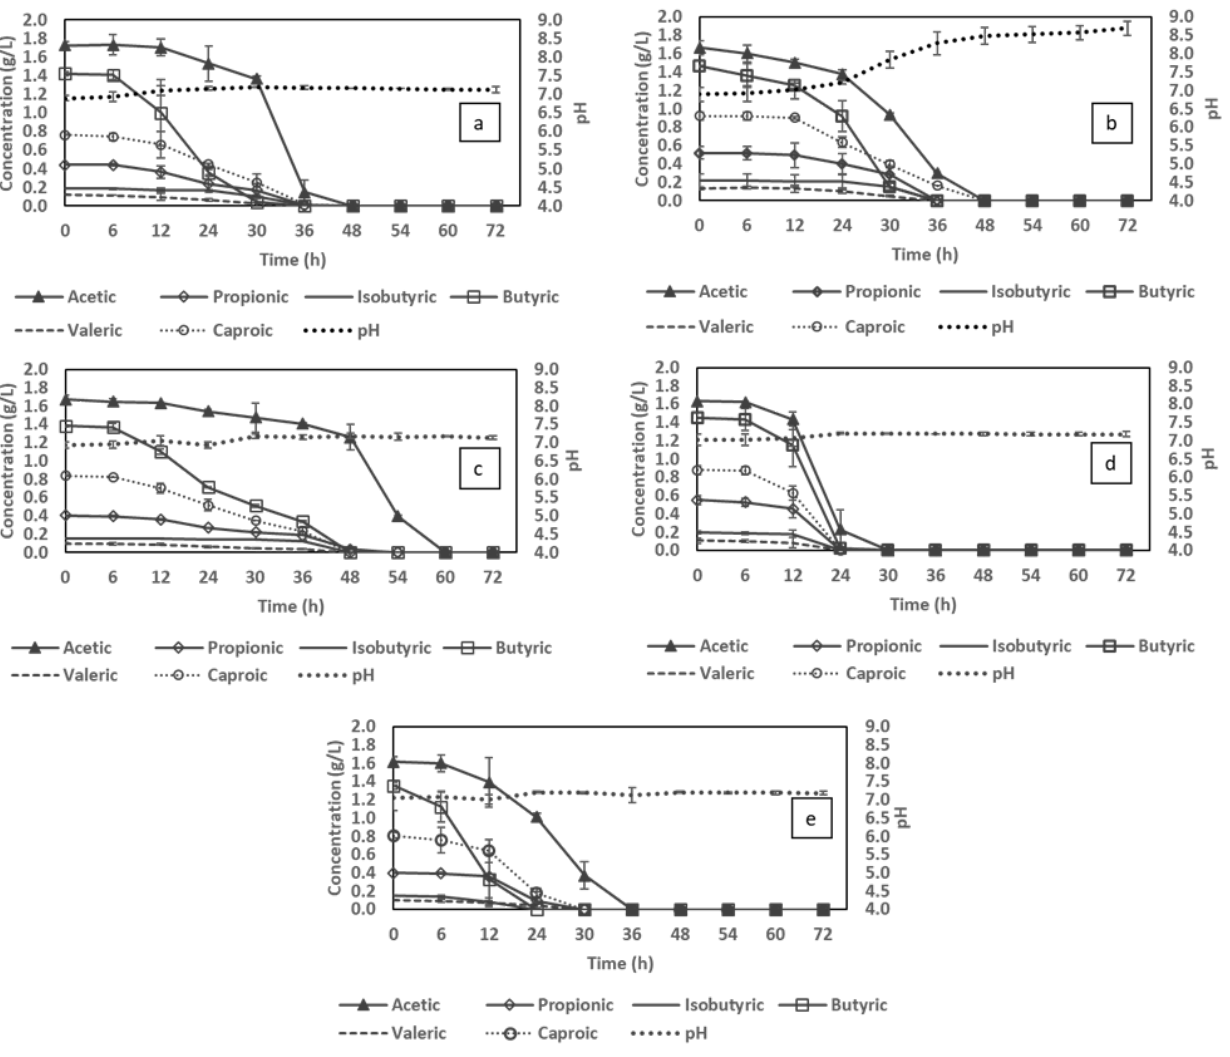
Figure 3. The effect of different cultivation factors (compared in pairs) on volatile fatty acid (VFA) consumption: pH control ( a ) vs. no pH control ( b ); C/N 6 ( a ) vs. C/N 12 ( c ); 1 vvm ( a ) vs. 0.25 vvm ( d ) and ammonium sulfate ( a ) vs. urea ( e ).